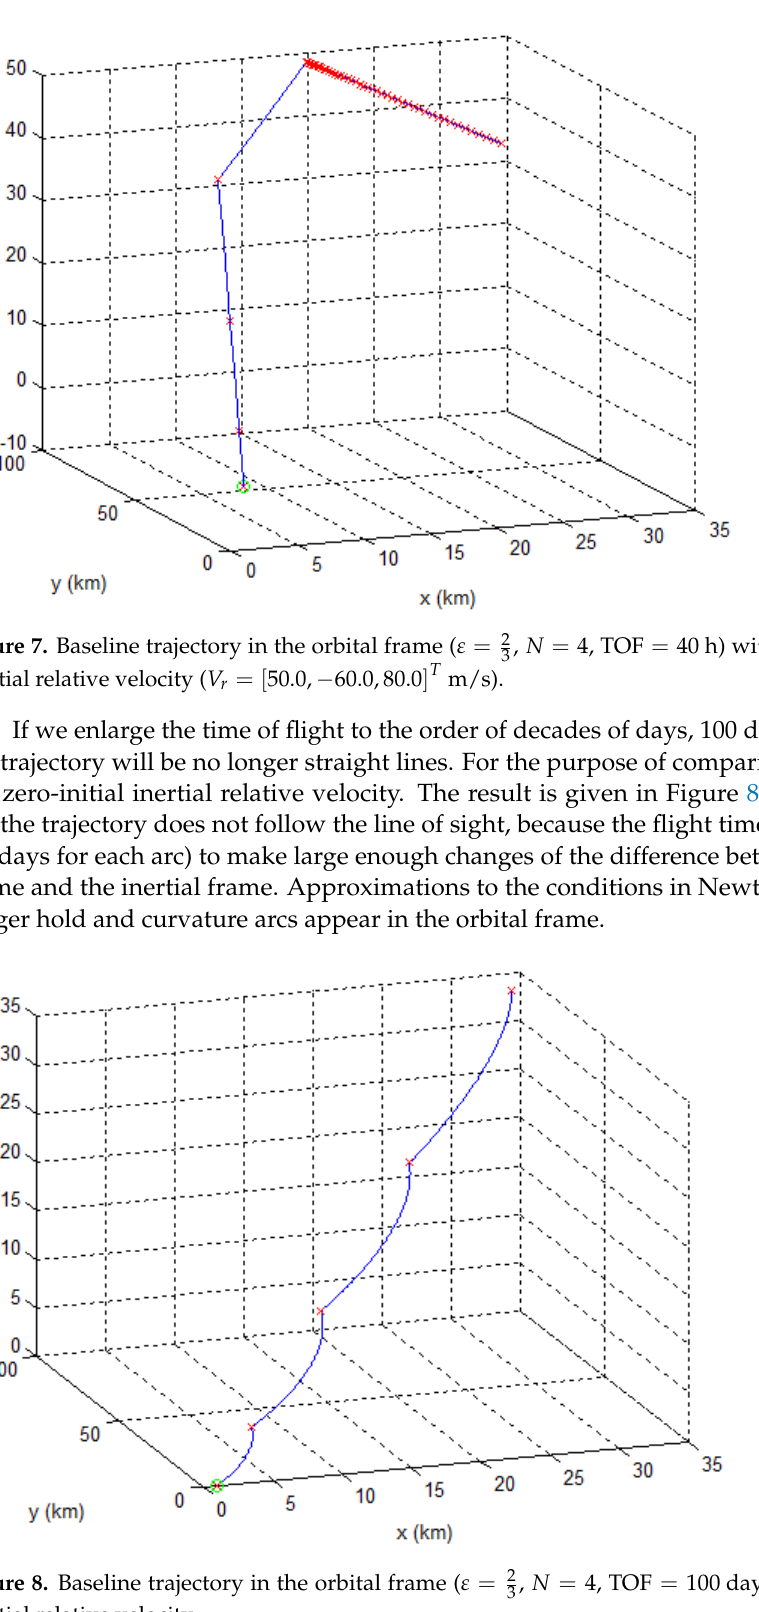
, N = 4, TOF = 100 day) with zero initial ε , = 4 N , = TOF 100 day ) with zero 3 3